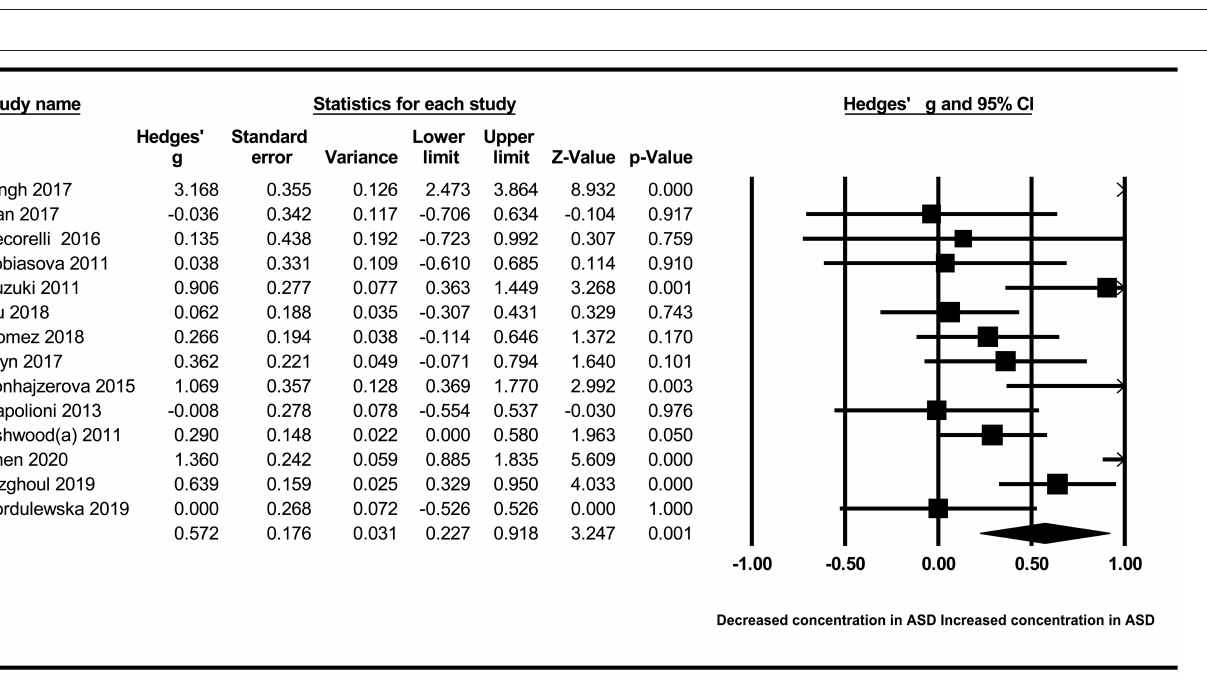
FIGURE 7 | Forest plot for the fixed-effects meta-analysis (MCP1).